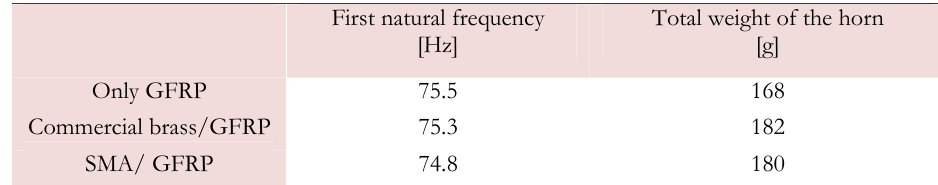
Table 6: First natural frequency and total weight of the three horn samples.